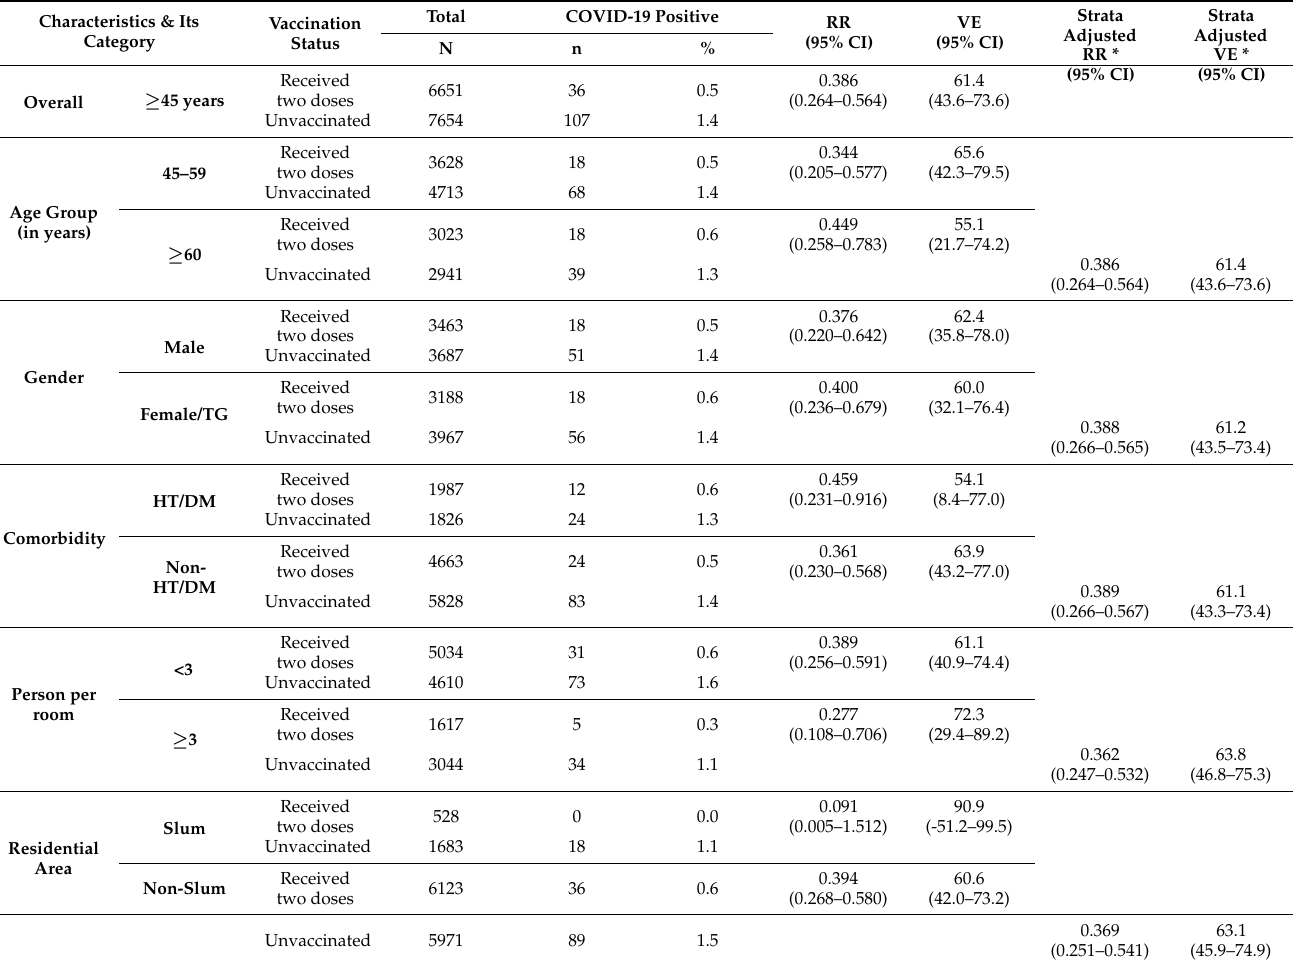
Table 4. Effectiveness of two doses of the Covishield vaccine against COVID-19 infection among individuals ≥ 45 years, Chennai, India (N =